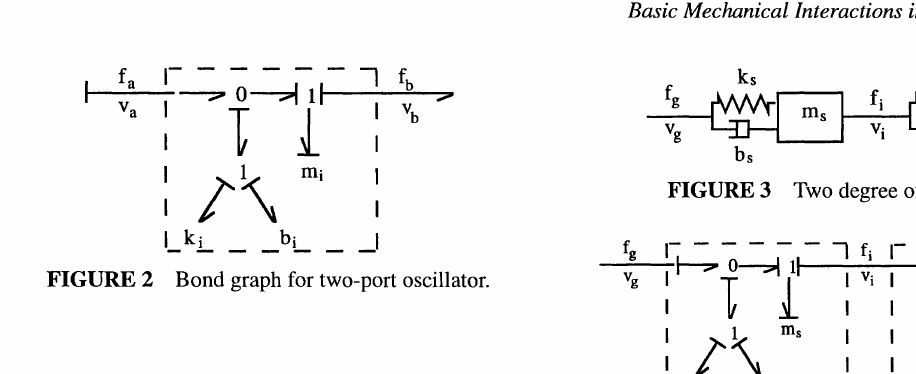
FIGURE 2 Bond graph for two-port oscillator.